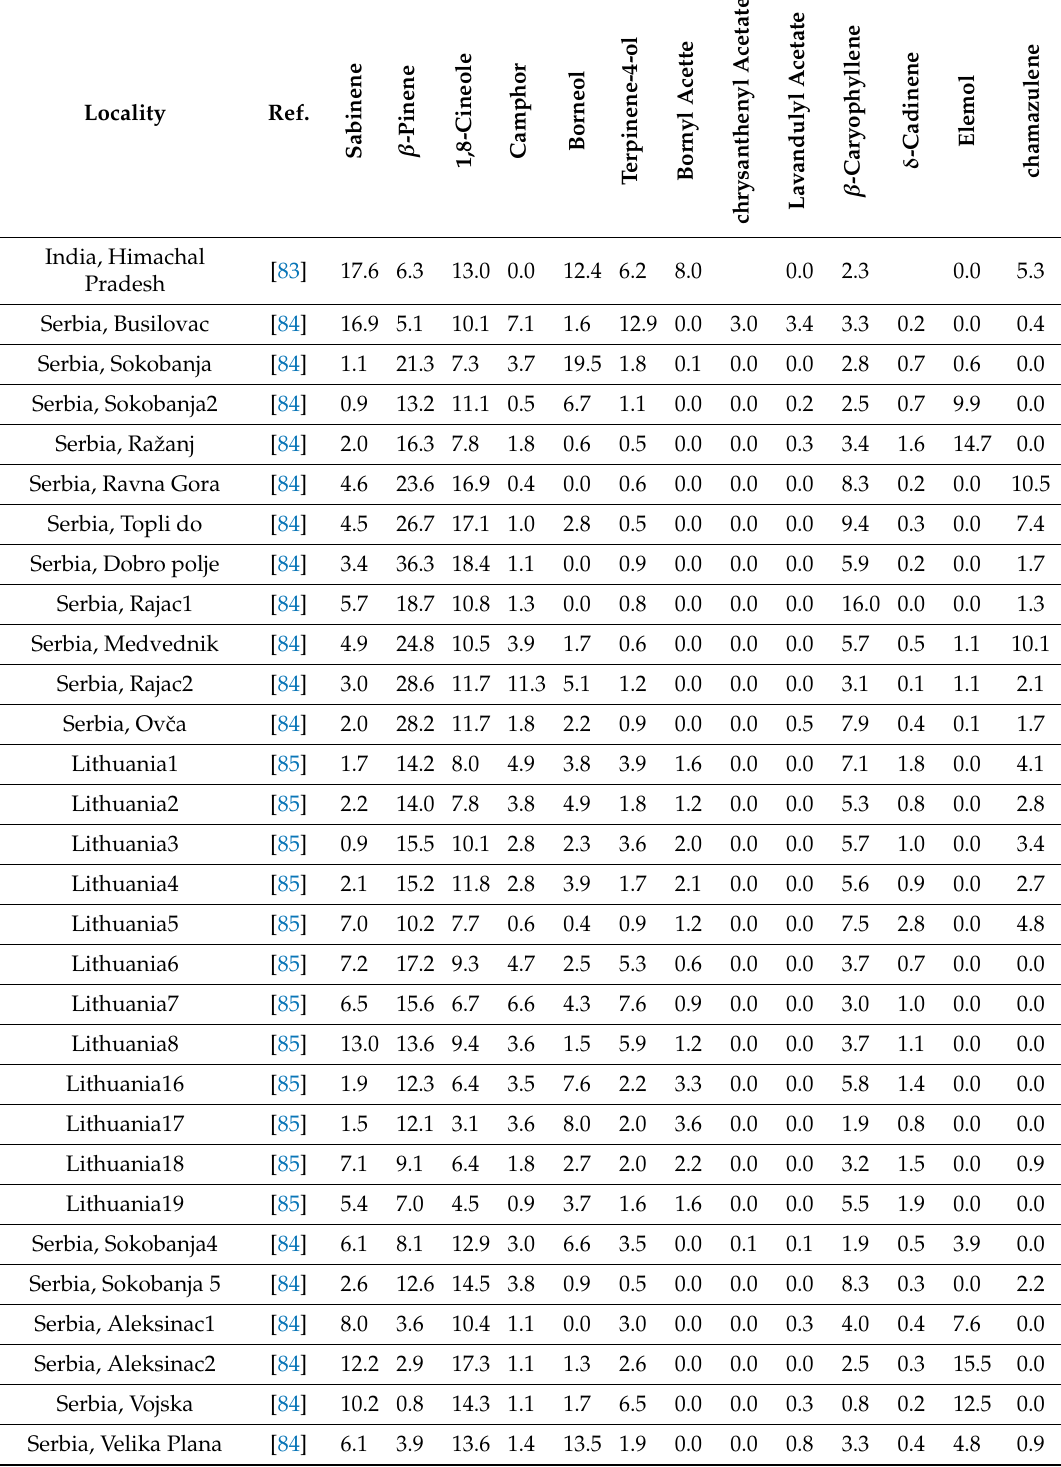
Table 6. A. millefolium EO constituents from this study and others reported previously in the literature.